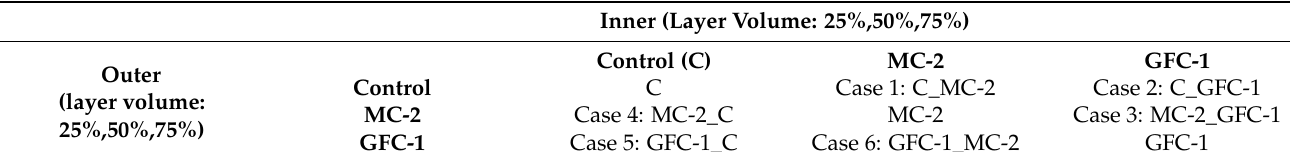
Table 5. Two-material multi-layer concrete case table.